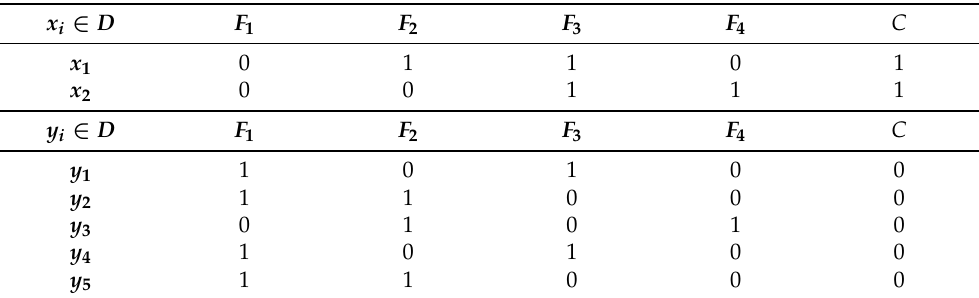
Table 3. An example dataset D with F = { F 1 , F 2 , F 3 , F 4 } and C = { 0,1 } . The data consist of two